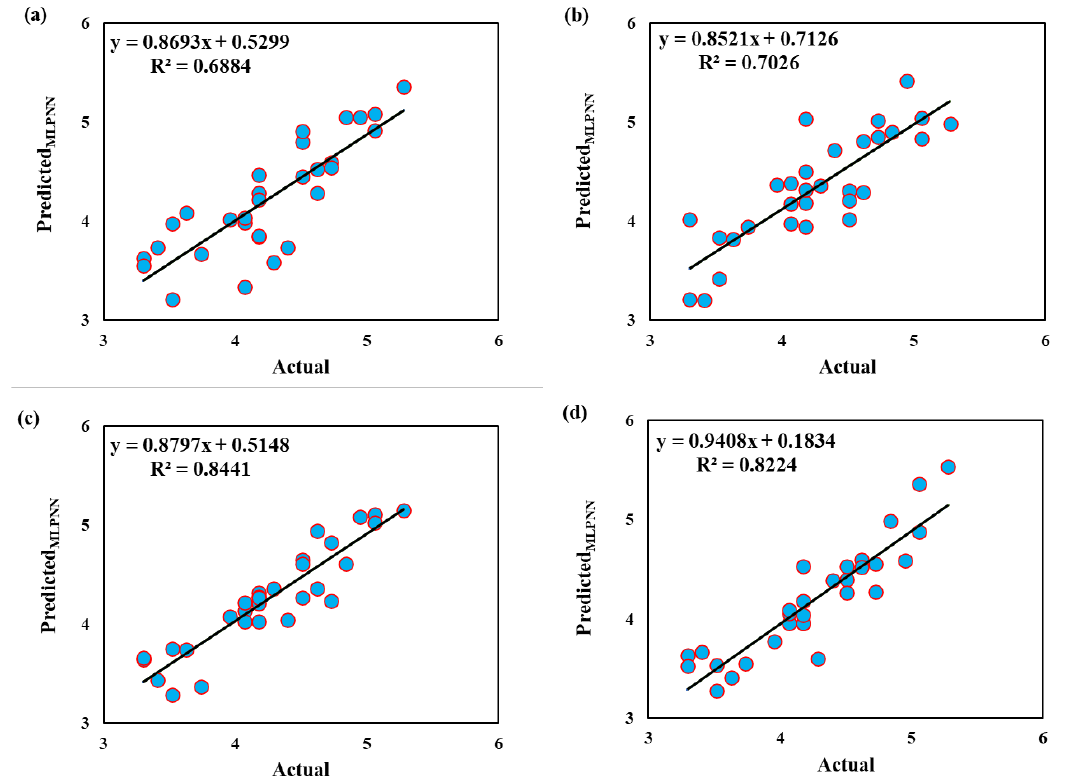
Figure 7. Scatter Plots for the MLPNN method: ( a ) Model-1; ( b ) Model-2; ( c ) Model-3; and ( d ) Model-4, respectively.